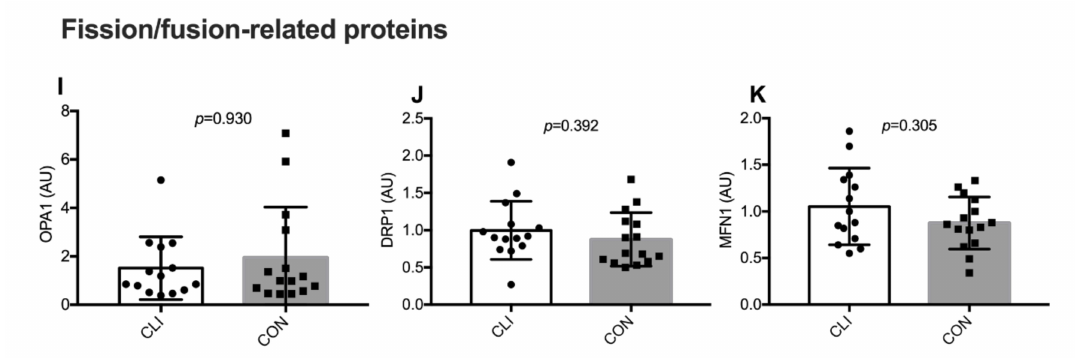
Figure 8. Expression of mitophagy and fission / fusion-related proteins for CLI (n = 14) and CON (n =